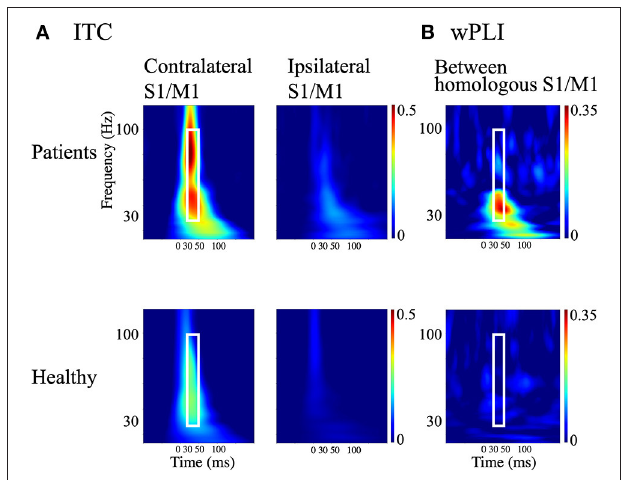
FIGURE 4 | Measures of cortical synchrony following median nerve stimulation. (A) Time-frequency plots of grand-averaged intertrial phase coherence (ITC) in contralateral and ipsilateral S1/M1 regions of interest (ROIs; left and right panels, respectively). (B) Time-frequency plots of weighted phase-lag index (wPLI) between homologous S1/M1 ROIs. Upper panels: patients with bilateral C-reflex; lower panels: healthy controls. White rectangles show the time window of 30–50ms and the frequency window of